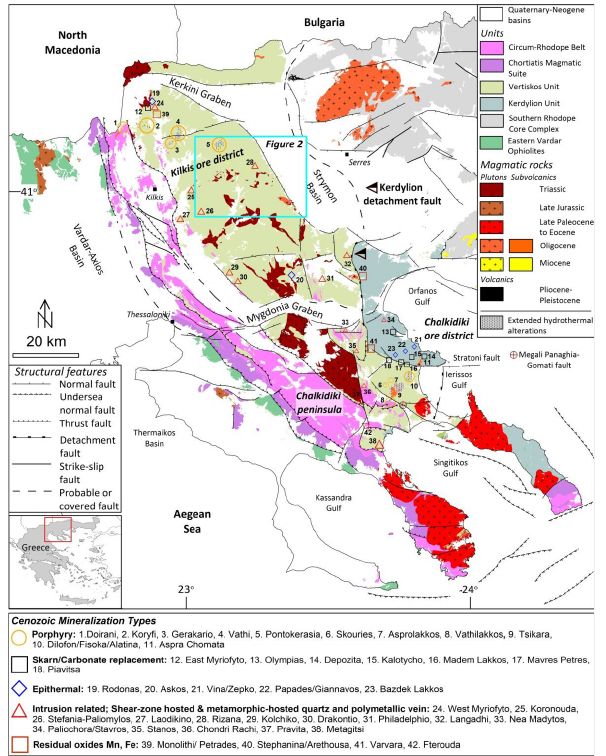
Figure 1. The geological setting of Cenozoic magmatism and related mineralization along the Vertiskos and Kerdylion Units (modified after [6,20,23,24]). At Rizana (also mentioned as Lachanas; Figure 1) the Sb deposit is hosted in a silici- fied brittle shear-zone crosscutting the basement metamorphic rocks. Locally, it is en- riched in W found as wolframite. Previous publications have explored the genesis, the mineral association and the potential ore application [31 – 35]. In this study, we present new data on mineralogy and geochemistry of the host two-mica gneiss and of the ore mineralization at Rizana, and we share formula calculations on stibnite, pyrite, sphalerite, chalcopyrite, berthierite and valentinite. In addition, we investigate the distribution of the critical metals in the mineralization after bulk geochemistry. Finally, based on microther- mometric data collected from the fluid inclusions in quartz from the stibnite mineraliza- tion, we highlight the ore forming history and fluid evolution at Rizana. The results